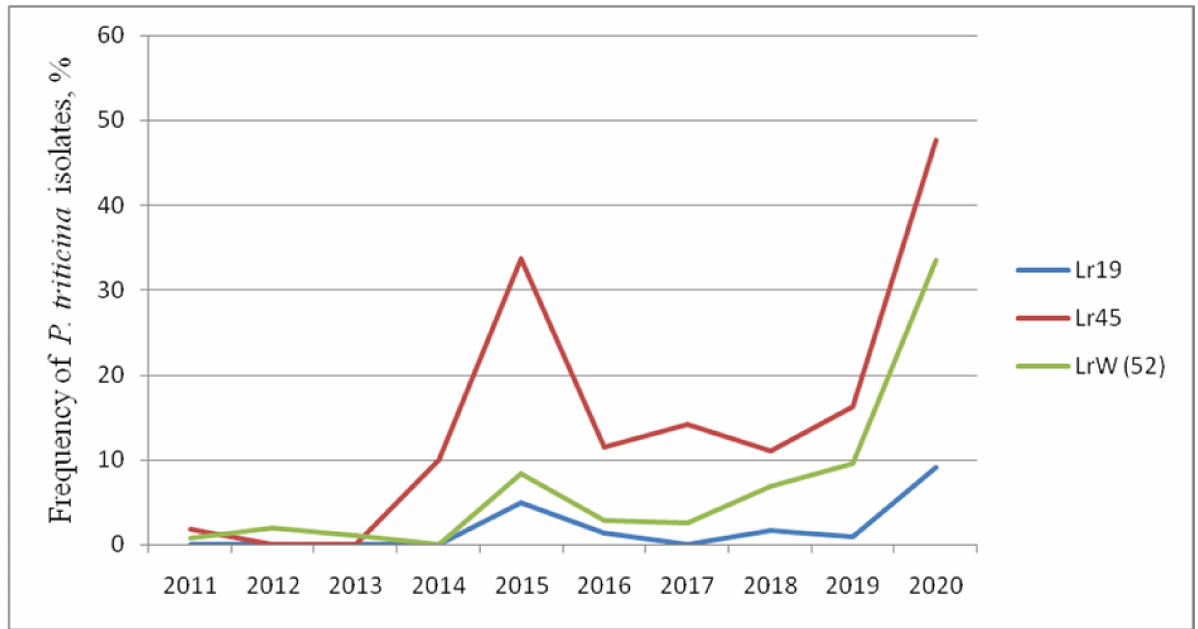
Figure 1. Efficiency dynamics of Lr genes in the seedling phase against the North Caucasian popula- tion of P. triticina